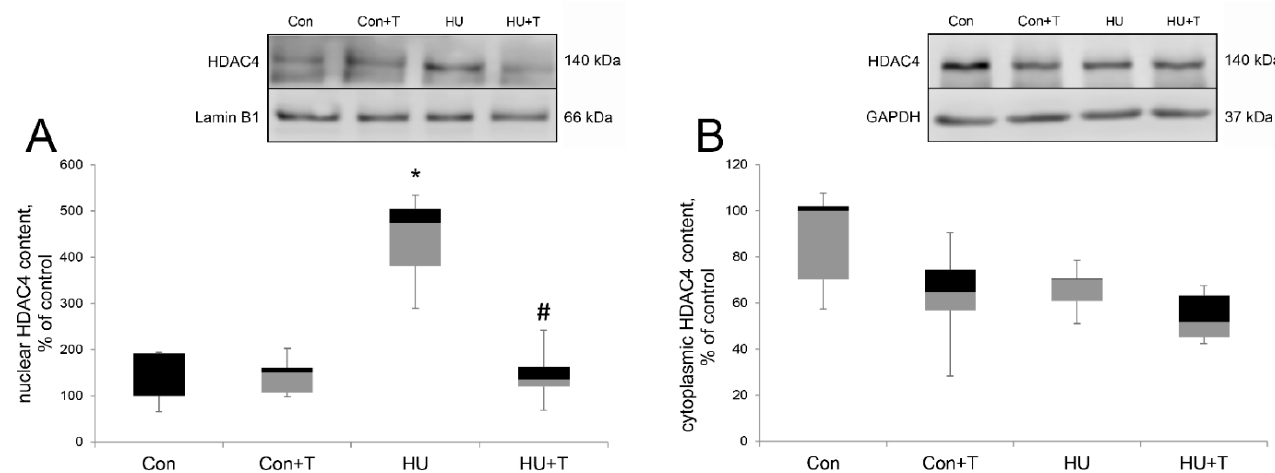
Figure 2. Western blot analysis of nuclear HDAC4 ( A ) and cytoplasmic HDAC4 ( B ) content in rat soleus muscle in control